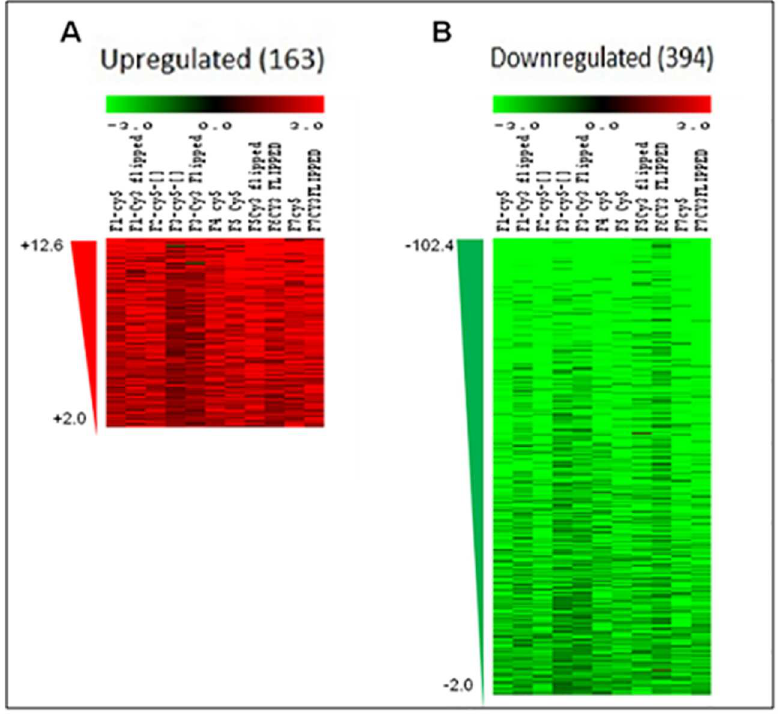
Fig 1. Heat map of the differentially expressedgenes in sputum from PTB patients using a mycobacterial whole genome microarray. A) Panel A shows the upregulatedgenes and B) panel B shows the downregulated genesin sputum from PTB patients as comparedto in vitro grown M . tb H37Rv. Red and green colouredtriangles represent the amount of fold upregulation or downregulation